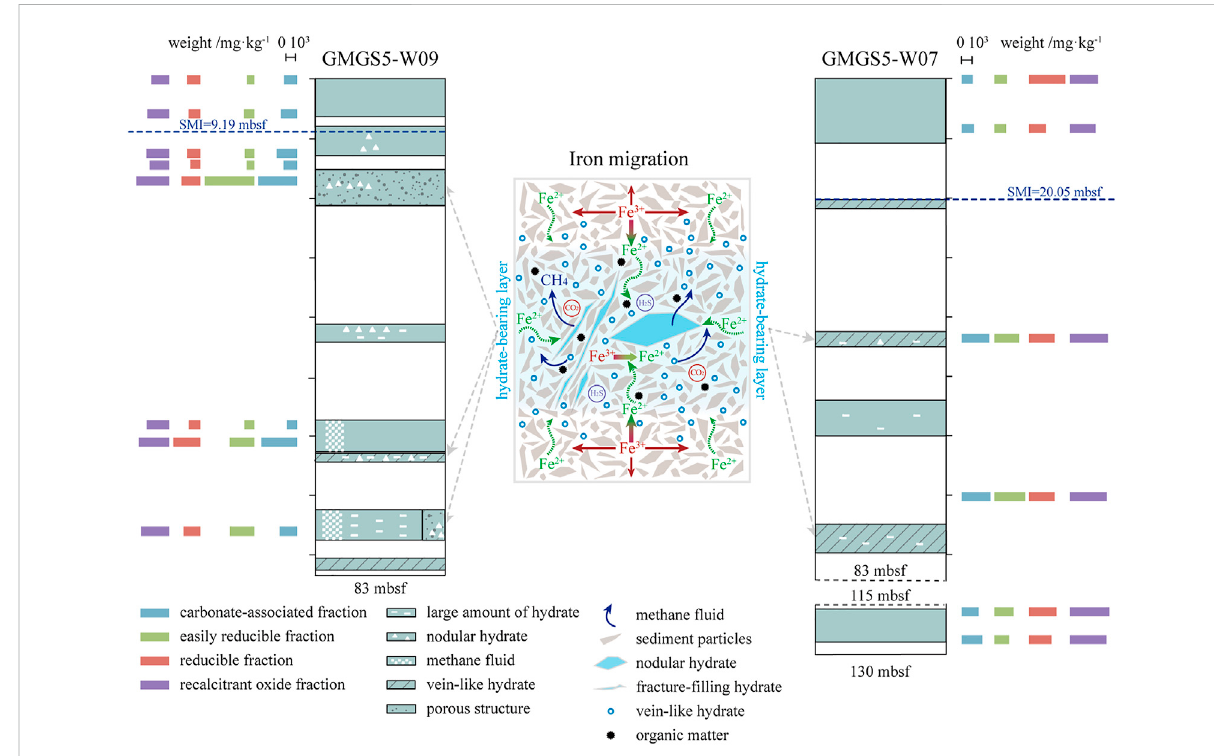
FIGURE 6 Gas hydrate accumulation at site W09 and W07 under X-CT image and drilling results (after Liang et al., 2019; Wei et al., 2019; Wei et al., 2021), different species of Fe from sequential extraction experiments results, and migration mechanism of